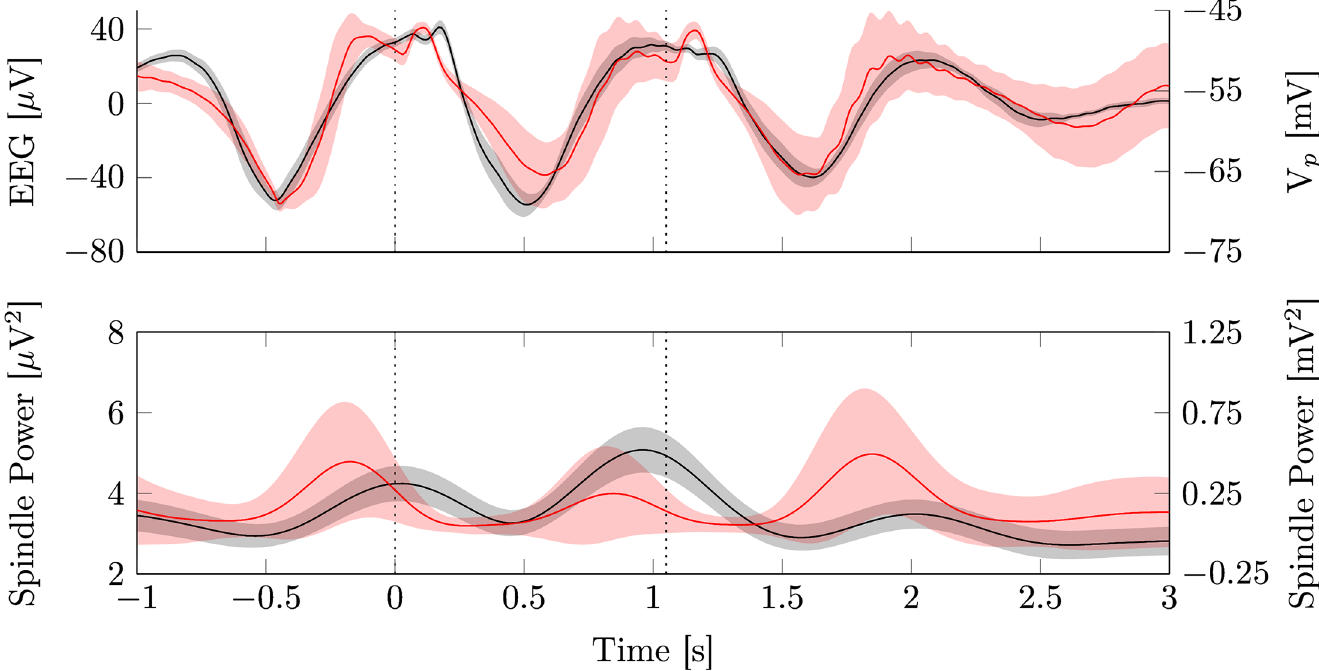
Fig 7. Closed loop stimulation. The upper panel depicts in black the mean ( ± SEM) evoked potentials of human EEG data from electrode Cz during closed loop stimulation, time locked to the first stimulus (11 subjects, 245.6 ± 38.1 stimuli). In red the reproduction of the stimulation protocol with the model is shown (mean ± SD, 88 stimuli). The dashed line marks the stimulus onset. The lower panel shows the corresponding fast spindle power. Parameters used for model simulation are given in Table